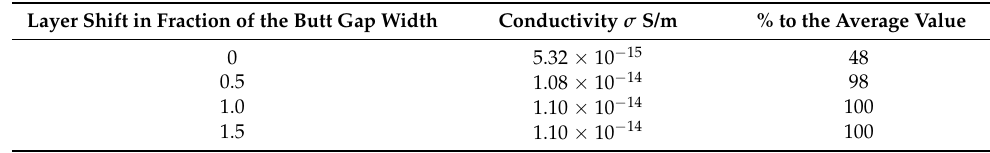
Table 4. Electrical conductivity of the insulation at different layer shifts. Layer Shift in Fraction of the Butt Gap